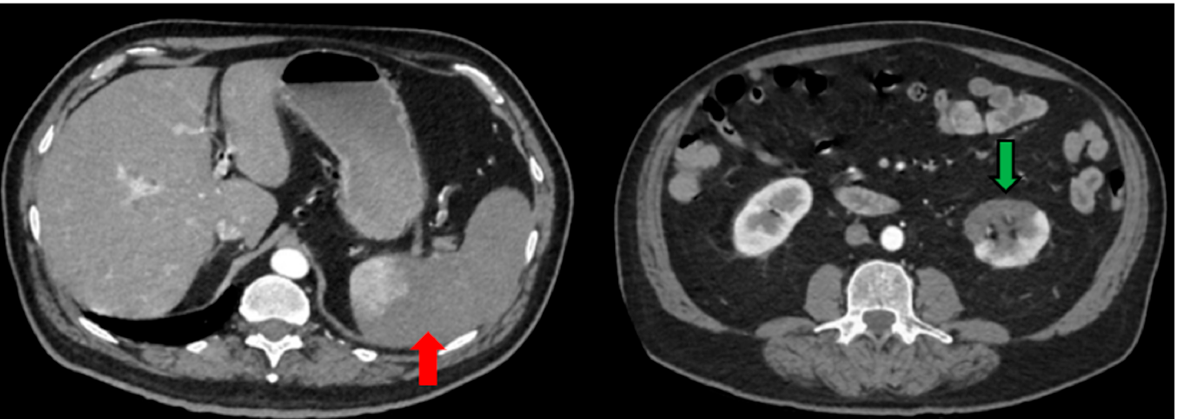
Figure 2. Abdominal CT scan of the patient at day 6. The red arrow demonstrates the area of hypoattenuation in the splenic parenchyma consistent with the splenic infarct. The green arrow indicates wedge-shaped parenchyma hypodensities in the lower lobe of the left kidney, typically seen in renal infarcts.